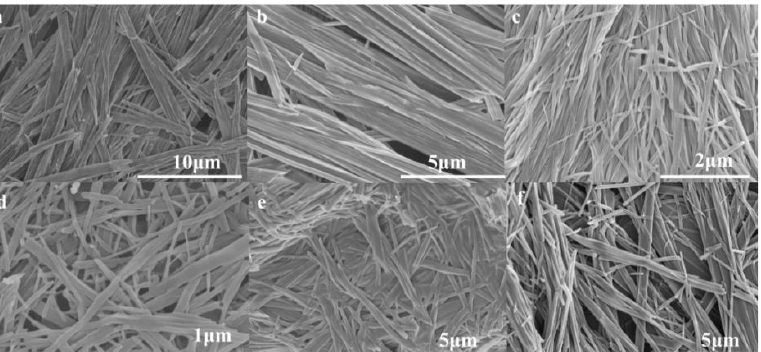
Figure 2. SEM images of xerogels of 1 in ( a ) DMF/H 2 O (4/1, v / v ), ( b ) acetonitrile, ( c ) ethyl acetate, ( d ) DMSO/H 2 O (4/1, v / v ), ( e ) ethanol, ( f ) methanol. ( d ) DMSO/H 2 O (4/1, v / v ), ( e ) ethanol, ( f )